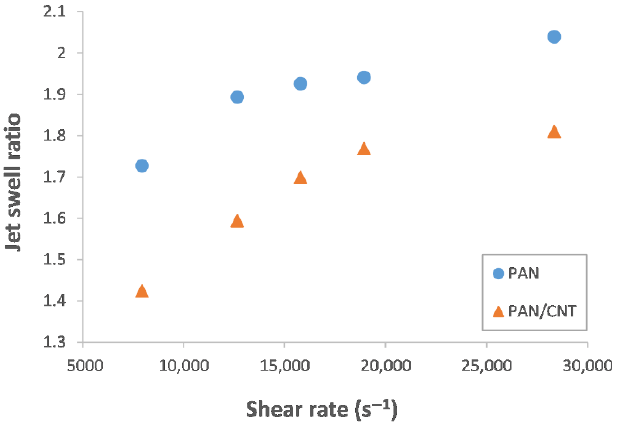
/ CNT fibers at di ff erent shear